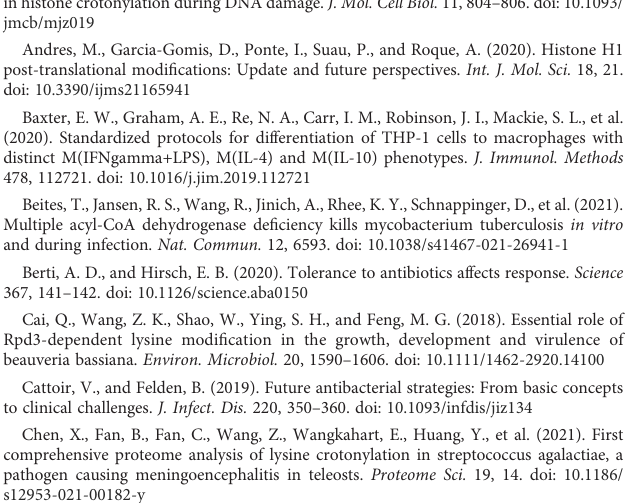
SUPPLEMENTARY FIGURE 1 Western blot analysis by pan-anti-crotonyllysine antibody of the lysates from uninfected THP-1 and uninfected THP-1 cells treated with Vancomycin. SUPPLEMENTARY FIGURE 2 Number of each peptide from proteomic analysis. SUPPLEMENTARY FIGURE 3 Thefeatureandnumberofpeptidesfromcrotonylation analysis.(A)Thepeptide length digested by trypsin. (B) The number of identi fi ed proteins. SUPPLEMENTARY FIGURE 4 Number of crotonylated sites from regulated